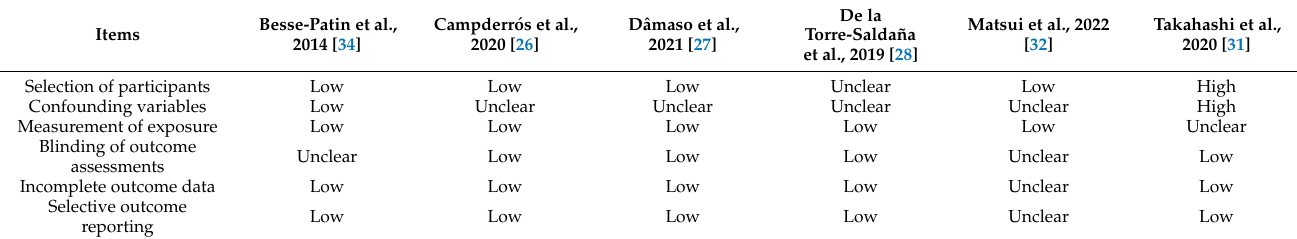
Table 1. Risk-of-bias assessment tool for non-randomized studies.